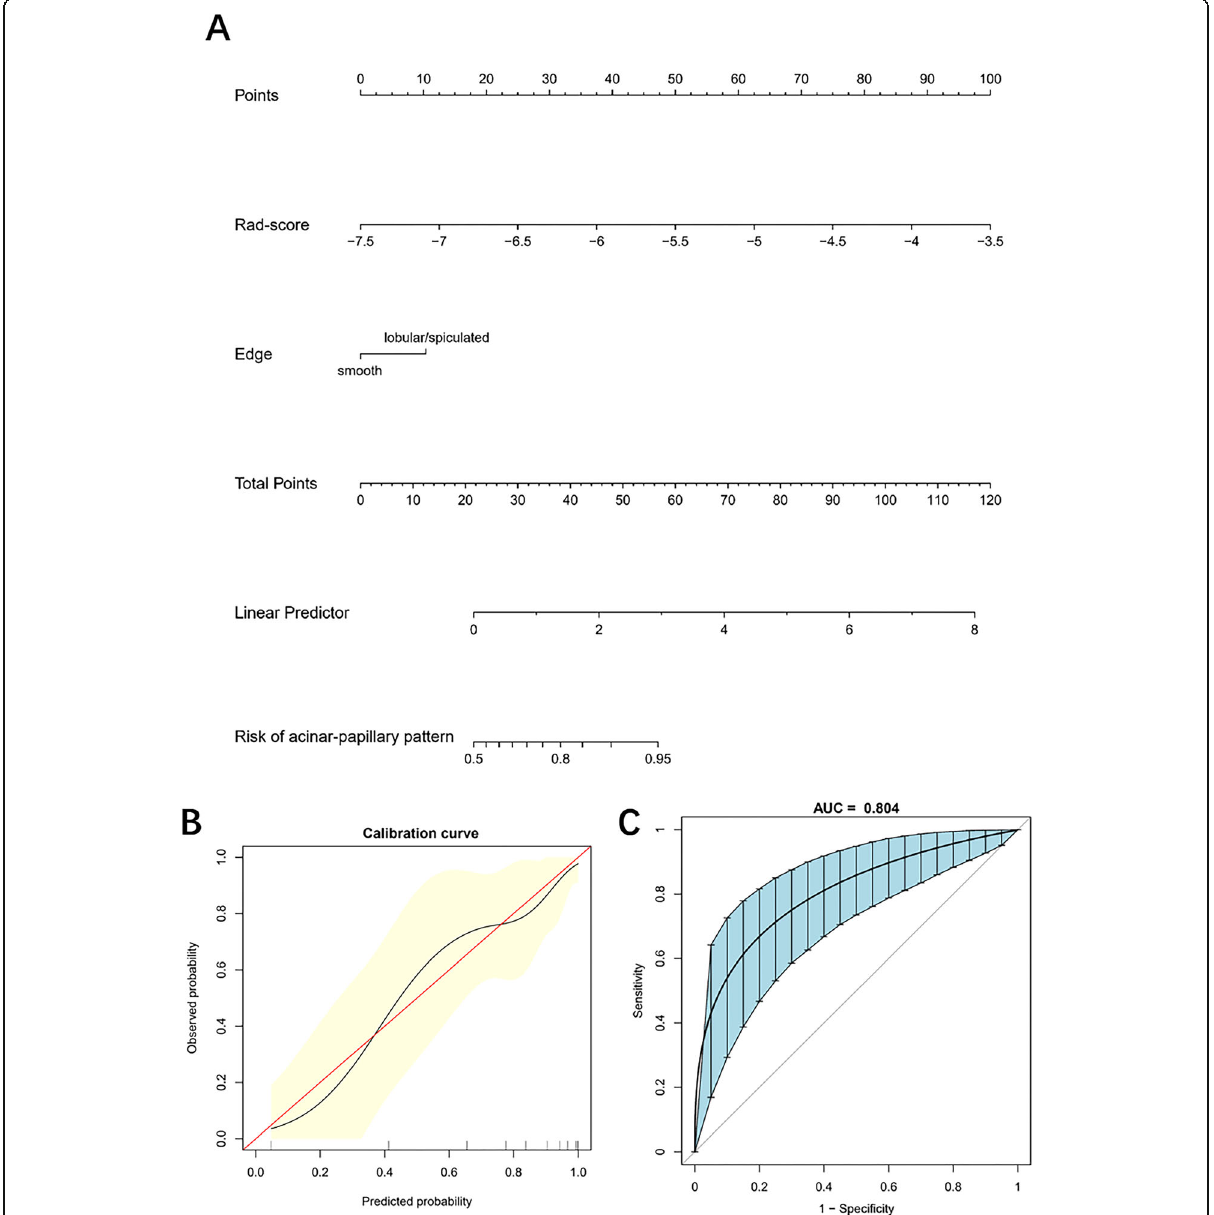
Fig. 4 The nomogram and its performance. The nomogram, calibration curve, and ROC based on the joint model (rad-score and edge) were drawn ( a – c ). b The horizontal axis of the calibration curve is the predicted incidence of the acinar-papillary pattern, and the vertical axis is the observed incidence. The red diagonal line is the reference line, indicating that the predicted value equals to the observed value. The black line is the calibration curve, and the yellow areas on both sides represent 95% CI. c The ROC curve and 95% confidence interval of the joint model were drawn by the Bootstrap resampling (times = 500). Rad-score, radiomics signature